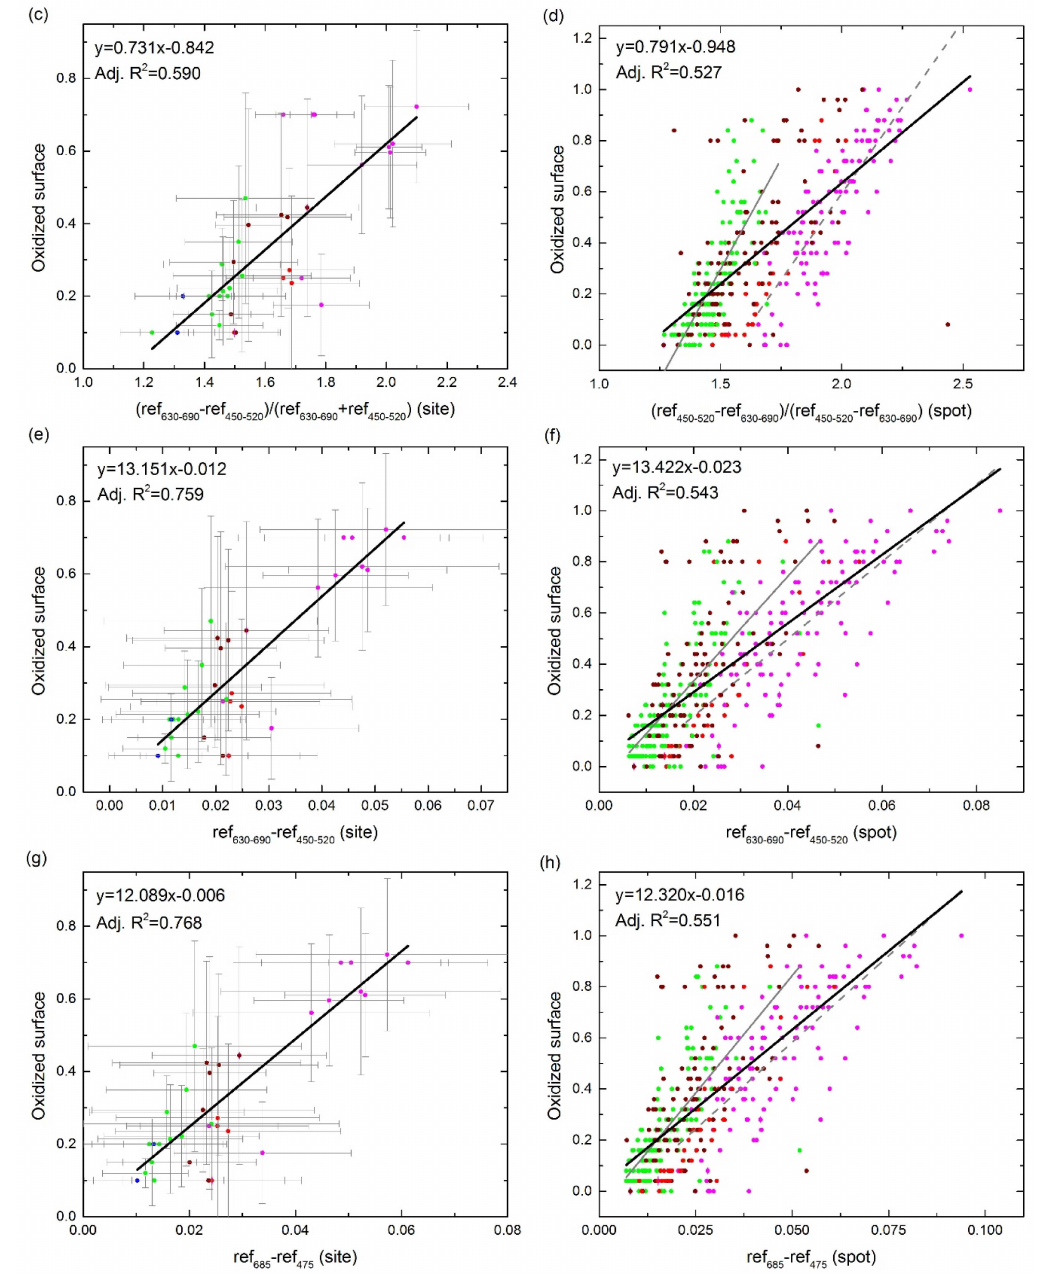
Figure 6. Relationship between lava surface oxidation estimated in the field and different oxidation indices (see Table A2) at site and spot scales. ( a ) (ref 800 ´ ref 400 ) vs. oxidation at site scale; ( b ) (ref 800 ´ ref 400 ) vs. oxidation at spot scale; ( c ) ((ref 630 ´ 690 ´ ref 450 ´ 520 )/(ref 630 ´ 690 + ref 450 ´ 520 )) vs. oxidation at site scale; ( d ) ((ref 630 ´ 690 ´ ref 450 ´ 520 )/(ref 630 ´ 690 + ref 450 ´ 520 )) vs. oxidation at spot scale; ( e ) (ref 630 ´ 690 ´ ref 450 ´ 520 ) vs. oxidation at site scale; ( f ) (ref 630 ´ 690 ´ ref 450 ´ 520 ) vs. oxidation at spot scale; ( g ) (ref 685 ´ ref 475 ) vs. oxidation at site scale; ( h ) (ref 685 ´ ref 475 ) vs. oxidation at spot scale. At site scale ( a , c , e and g ), data for 35 sites is plotted including lava sites measured on Boca Cangrejo, Chahorra, Chinyero, Fasnia and undated lava flows in 2013 and 2014; at spot scale ( b , d , f and h ), there are 415 spots belonging to the sites measured on Boca Cangrejo, Chahorra, Chinyero and undated lava flows in 2014. Only sites and spots with no or limited lichen coverage were used to constrain the relationships. Standard deviations were calculated for the field oxidation observations and spectral indices for each site. The solid line and dashed line at different slopes represent the trend lines for the young and old lava sites, respectively.